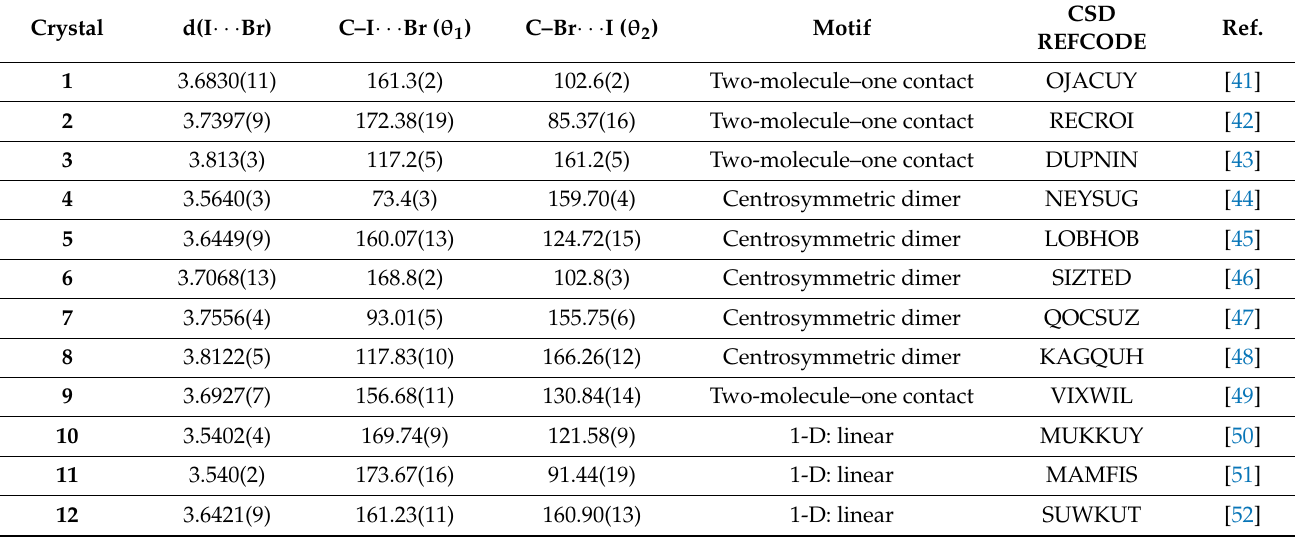
Table 1. Summary of geometric parameters (Å, ◦ ) and aggregation features for 1 – 41